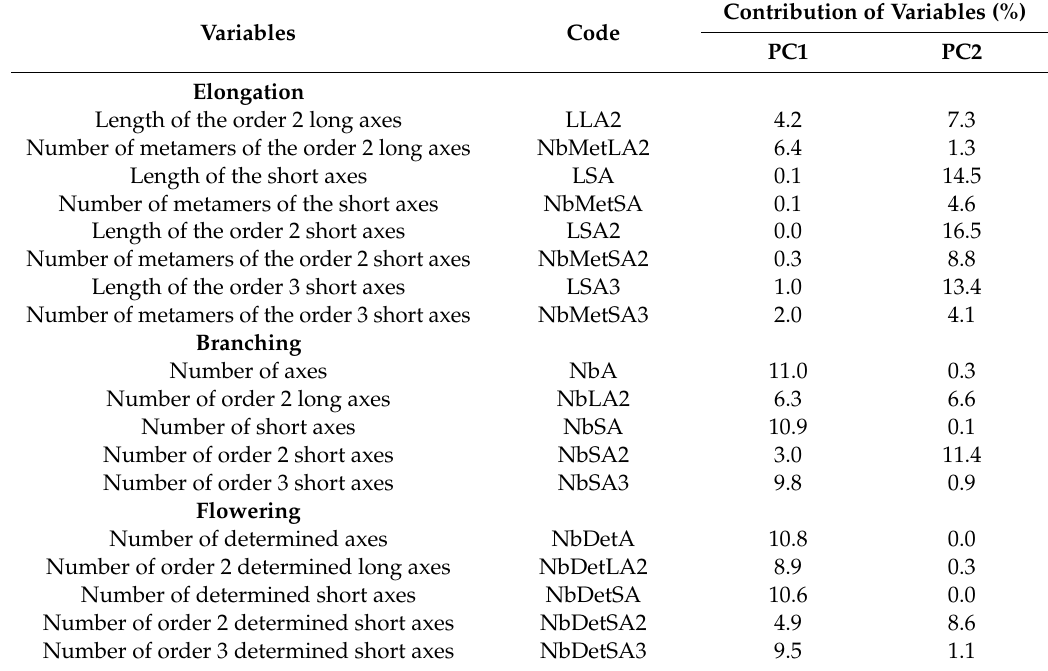
Table 3. List of the architectural variables measured at measurement point 2 according to the three defined categories (elongation, branching, and flowering), and contribution of these variables to the formation of principal components (PC) 1 and 2 of the principal component analysis. Contribution of Variables (%) Variables Code PC1 PC2 Elongation Length of the order 2 long